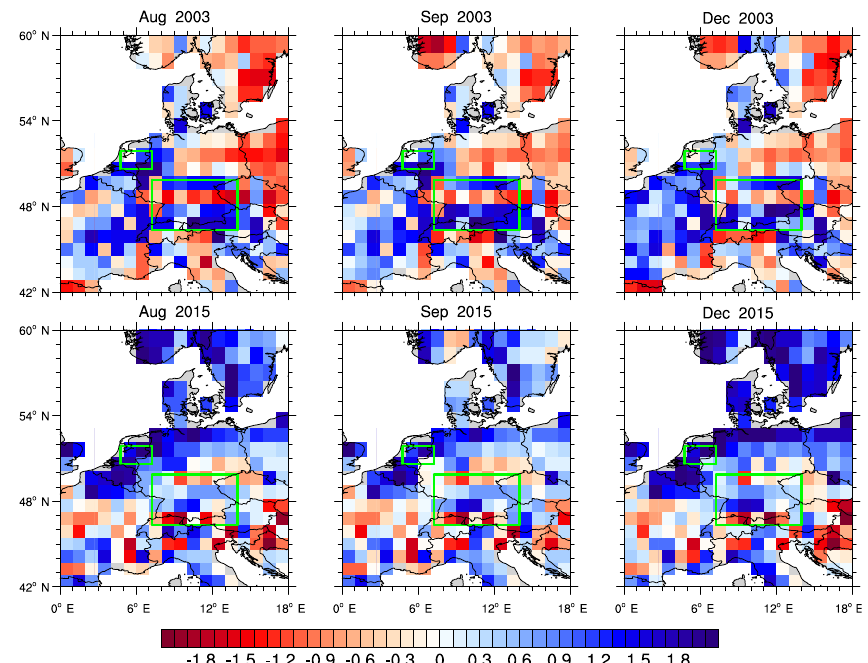
Figure A4. Same as Fig. A1, but after standardisation of the GRACE-MOSAIC groundwater anomalies to de-emphasise the seasonality component of the anomalies.